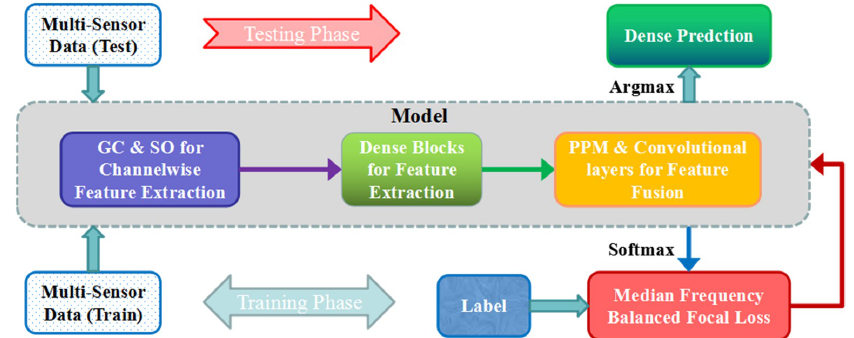
Figure 1. The general illusion of the training and testing procedure for a dense pyramid network (DPN). GC: group convolutions, SO: shuffling operation, PPM: pyramid pooling module.